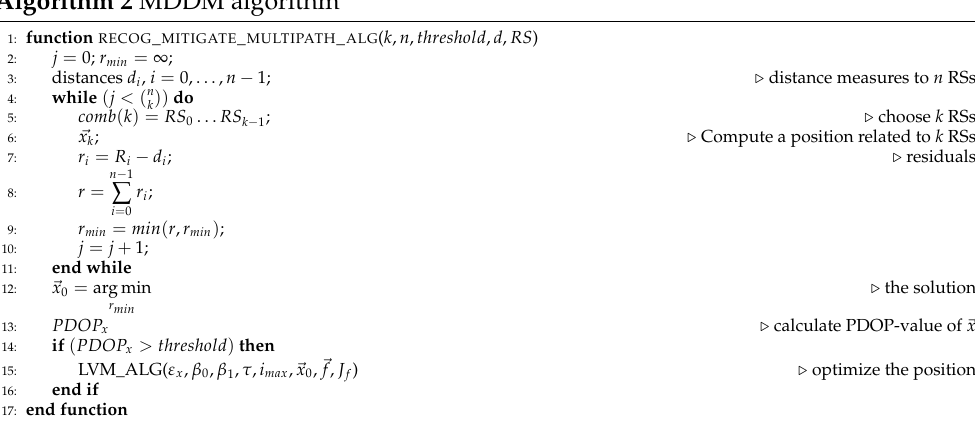
Algorithm 2 MDDM